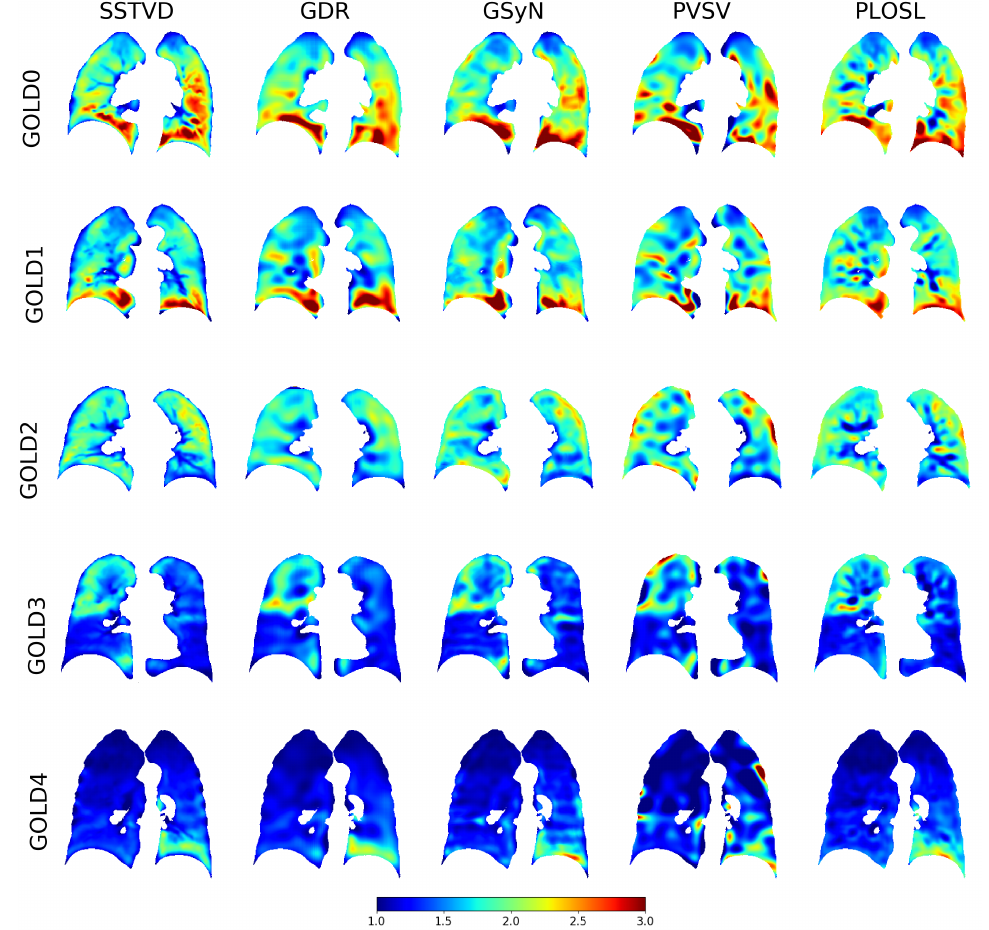
Figure 5. Typical Jacobian determinant images for each GOLD stage and registration algorithm. Dark red regions correspond to regions of large local expansion and dark blue regions correspond to regions with little to no expansion. This figure shows that each algorithm produced similar results for each GOLD stage and that the amount of local lung expansion decreased as the GOLD stage